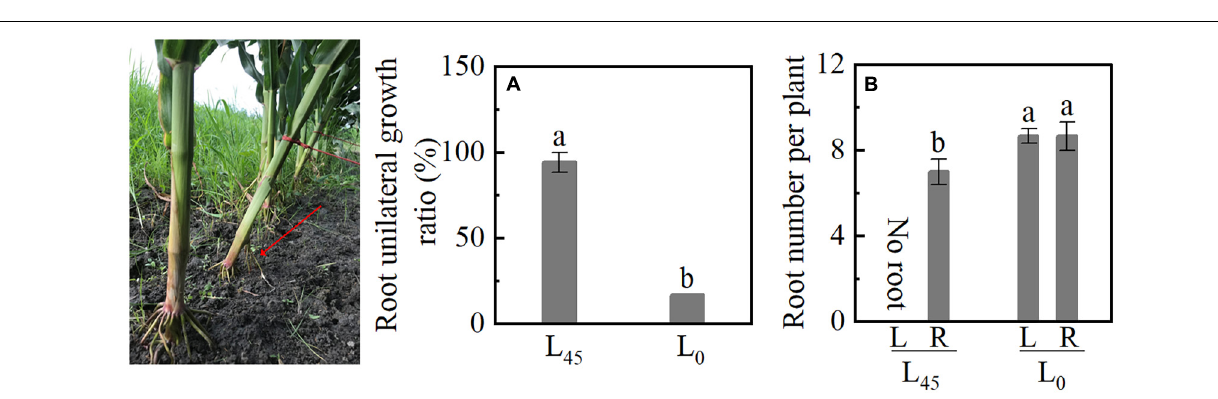
FIGURE 8 | Unilateral root growth ratio of plant inclination experiment in Study 3. L 45 : pull the plant with a rope and tilted it 45 ◦ . L 0 : plant erect of maize (L 0 ). (A) The brace unilateral root growth ratio. (B) The number of brace roots on the left and right sides. Data with the different letters are significantly different ( p <